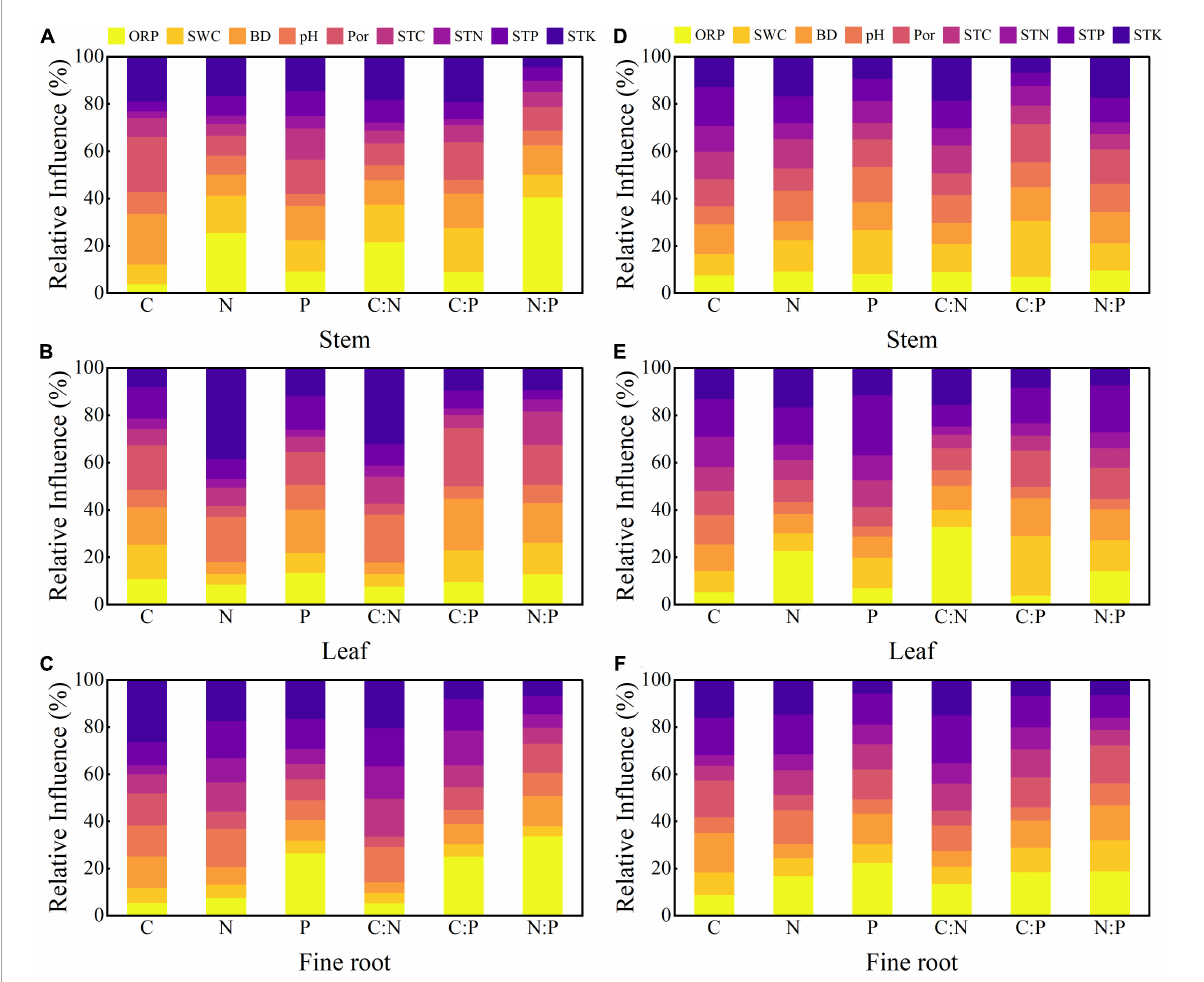
FIGURE8 Relative variable importance plots (%) of C, N, and P concentrations and stoichiometry for Taxodium ascendens (A–C) and Taxodium distichum (D–F) by random forest models. ORP, soil oxidation-reduction potential; SWC, soil water content; BD, soil bulk density; pH, soil pH value; Por, soil porosity; STC, soil total carbon; STN, soil total nitrogen; STP, soil total phosphorus; STK, soil total